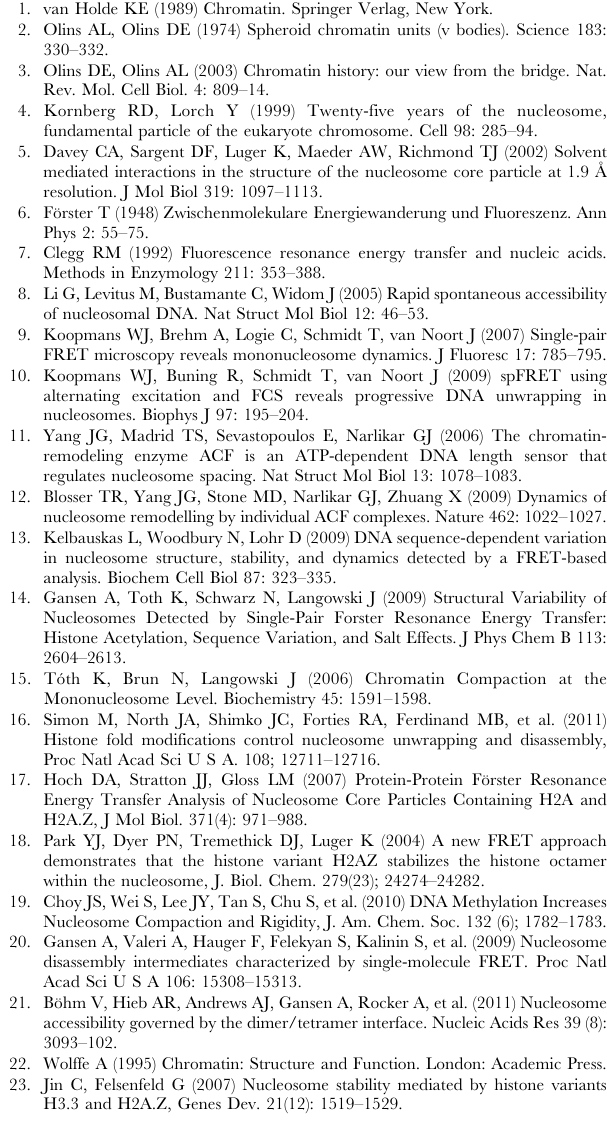
Table S1 Statistical distribution momenta for smFRET histograms between 150 mM and 600 mM NaCl. Table S2 Comparison of absolute FRET efficiencies from smFRET, m psFRET and the helical model of